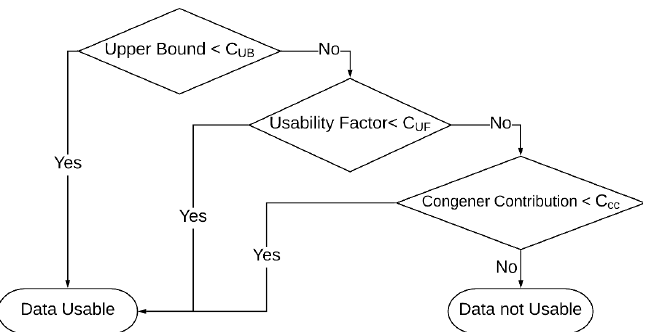
Figure 2. The flowchart for determining the usability of Target Data. C UB , C UF , and C CC are sample upper bound objective, usability factor objective, and congener contribution objective, respectively.